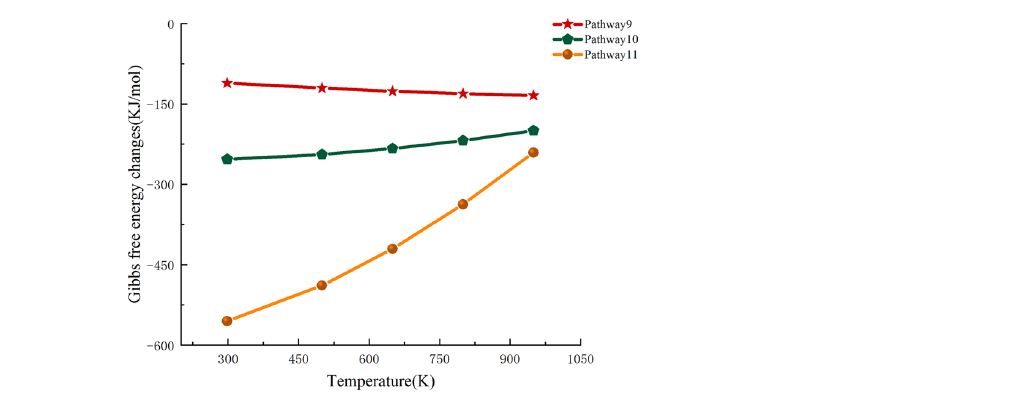
Figure 4. Gibbs free energy Δ G relationship diagram for pathway 9–11.